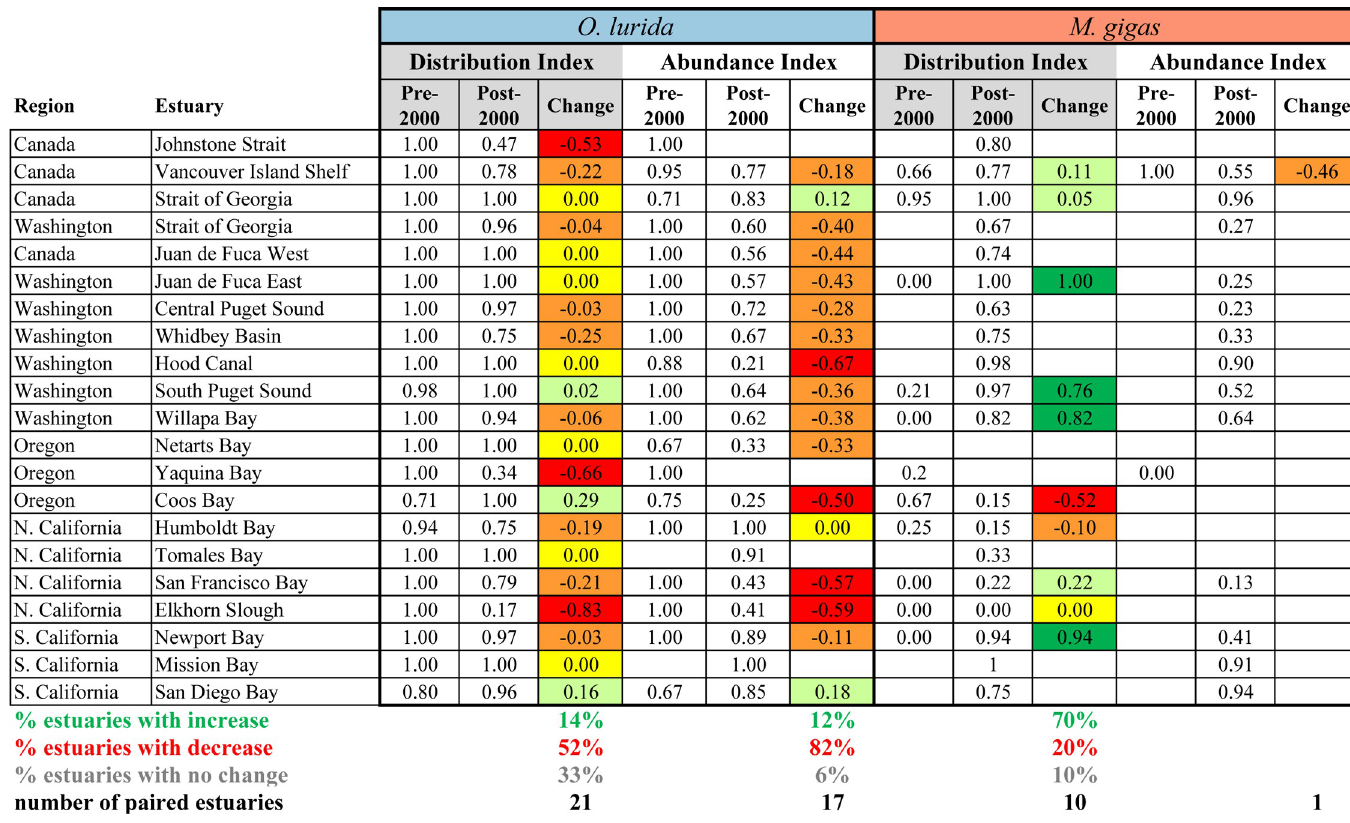
Fig 8. Distribution and abundance indices across estuaries over time. The index is shown for estuaries if at least three records were available for the time period. Estuaries were included in this table only if at least one species had three records for both periods for at least one index. Blank cells indicate that fewer than three records were available. The change in the index at each estuary is shown if data are available for both